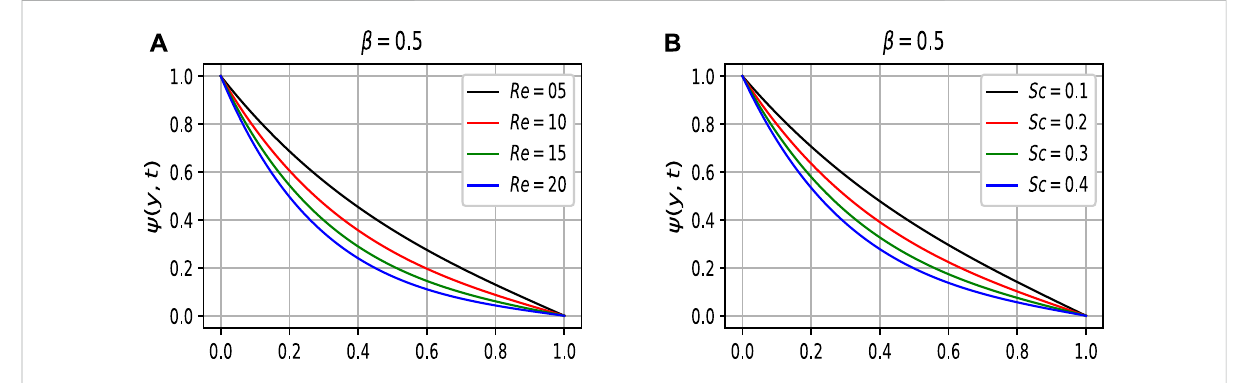
FIGURE 8 The behaviour of the boundary layer concentration as the parameters β and time ŧ